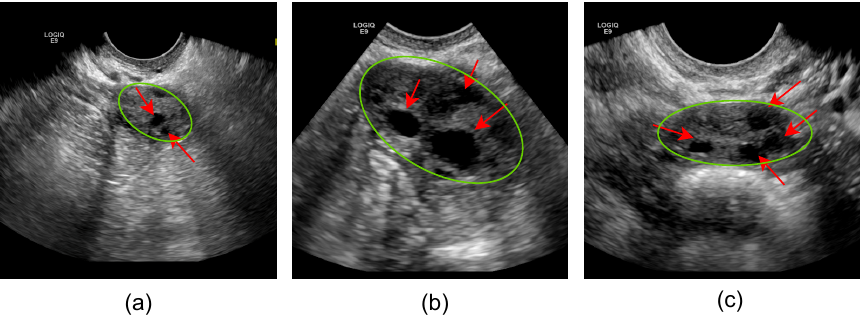
Figure 1. Illustration of three examples from the ovary dataset. Here, examples ( a – c ) show the ovary and follicles highlighted by the green circle and red arrows